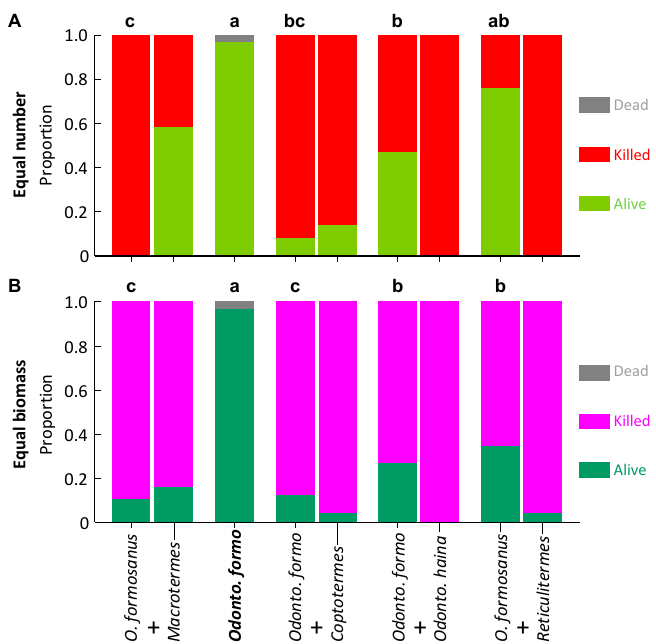
Figure 2. Survival of Odontotermes formosanus in laboratory aggression experiments. The control appears as a single column as it contains one species, whereas paired species treatments are paired columns, the O. formosanus on the left of each pair. Columns surmounted by different letters signify significantly different proportion survival (Bonferroni corrected pairwise comparisons) for O. formosanus . ( A ) Equal number of termites; ( B ) Equal biomass of termites.